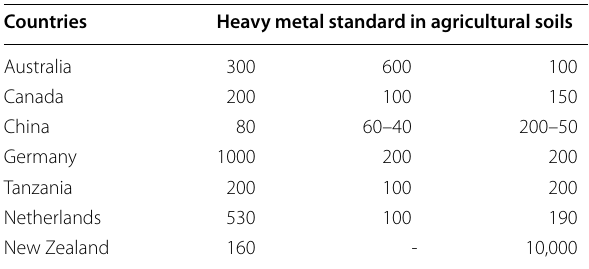
Table 6 Heavy metal standard in agricultural soils in different